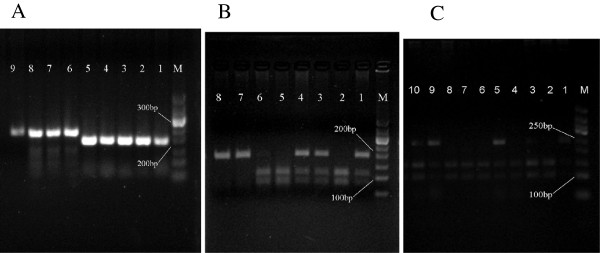
The electrophoresis results of the PCR products and digested products of CYP2C19*2 and CYP2C19*3. A: The PCR products of CYP2C19*2 and CYP2C19*3. Lane M: DNA Marker (50bp~500bp), Lane 1~5: CYP2C19*2, Lane 6~9:CYP2C19*3. B: Digested products of CYP2C19*2. Lane M: DNA Marker (50bp~500bp), Lane 1,3,4: heterozygous, Lane 2,5,6: wild-type, Lane 7,8: homozygous. C: Digested products of CYP2C19*3. Lane M: DNA Marker (50bp~500bp), Lane 1: homozygous, Lane 2,4,6,7,8: wild-type, Lane 3,5,9,10: heterozygous.